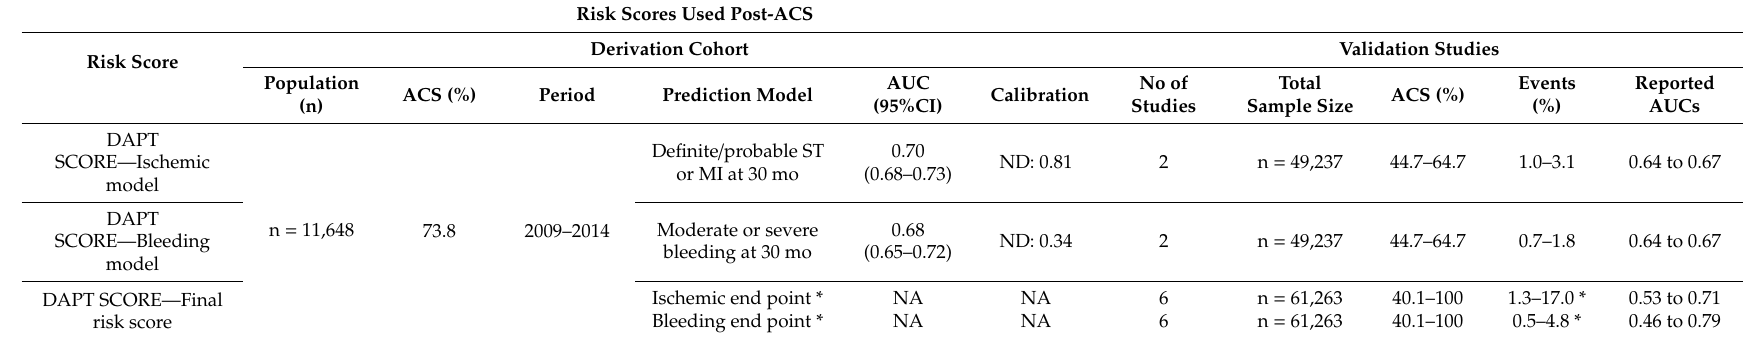
Table 3. Risk scores used